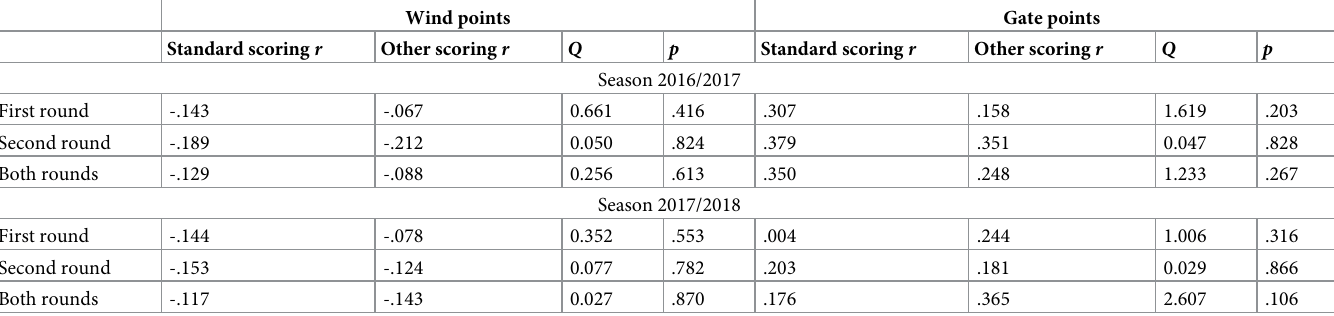
Table 2. Mixed-effects subgroup analyses for wind and gate point effects according to scoring modes of different competition